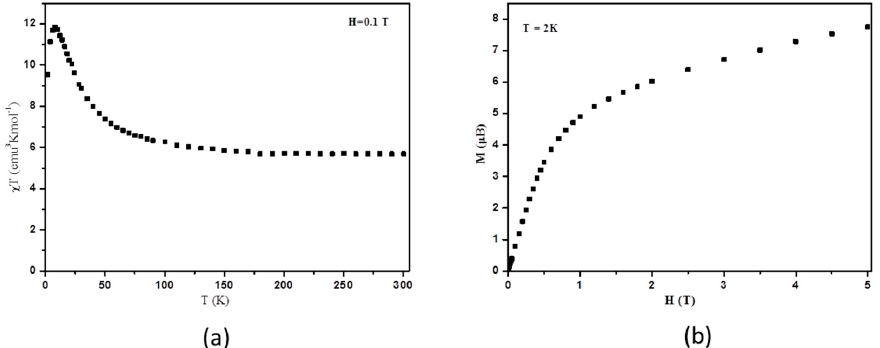
Figure 2. Magnetic behavior of a polycrystalline sample. ( a ) Temperature dependence of the product of the magnetic susceptibility with temperature ( χ T ) under an applied field of 0.1 T. ( b ) Field dependence of magnetization at 2 K.